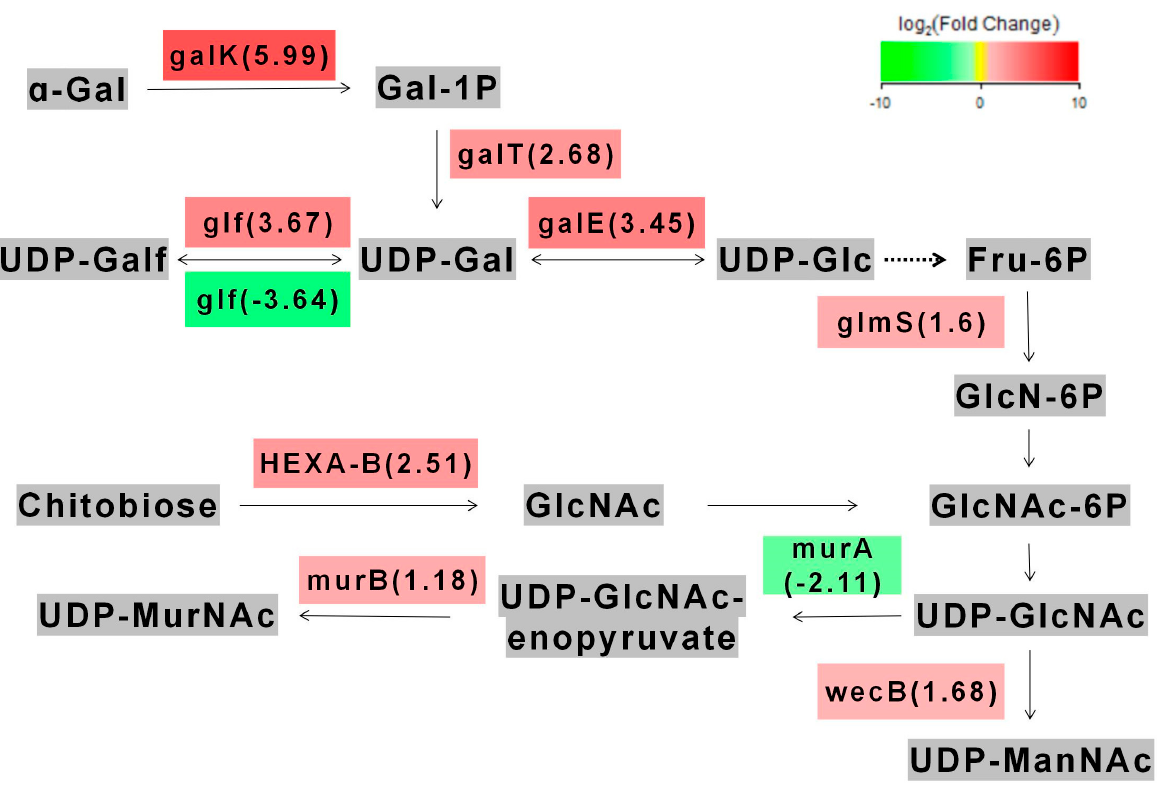
Fig. 5 The main metabolic pathways affected by galU gene Figure 5. The main metabolic pathways affected by galU